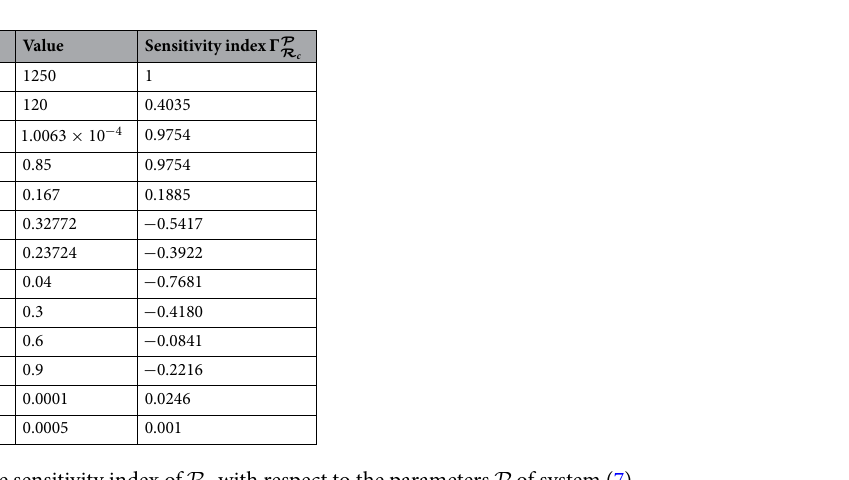
Table 2. The sensitivity index of R c with respect to the parameters P of system